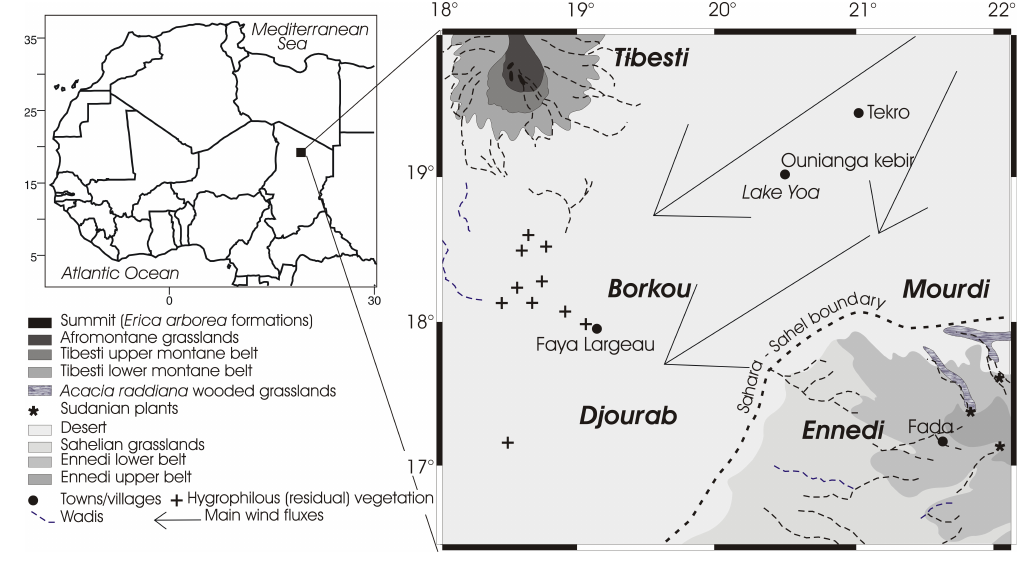
Fig. 1. Synthetic vegetation map of Faya Largeau (redrawn from Qu´ezel, 1964 and Capot-Rey,